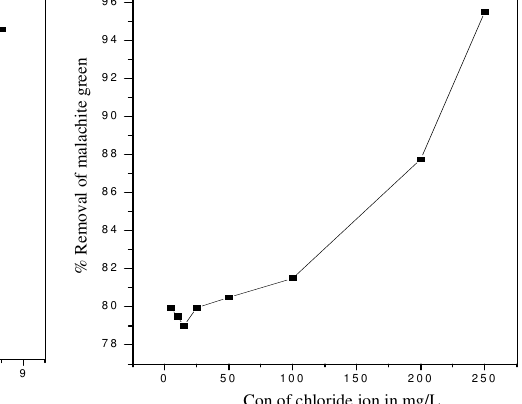
Figure 7. Effect of other ions on the adsorption of malachite green onto ZDC [M G] 30 mg/L; adsorbent dose = 25 mg/50 mL; Temp 30 o C; contact time 60